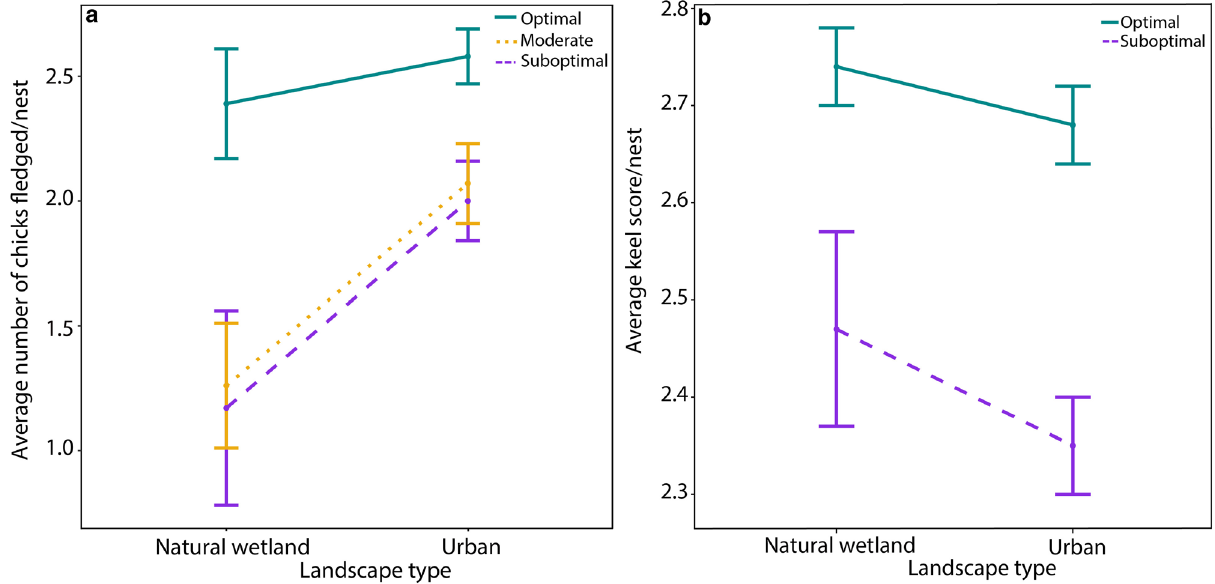
Figure 1. Productivity and body condition (mean ± SE) of storks across landscape type (urban and natural wetland) and hydrologic condition (suboptimal, moderate, optimal) in South Florida, 2015–2017. ( a ) Average number of chicks fledged per nest (productivity) across landscape type and hydrologic condition. ( b ) Average keel score per nest (body condition) across landscape type and hydrologic condition (suboptimal and